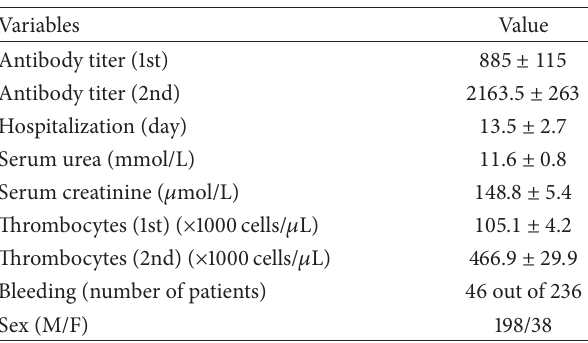
Table 1: Clinical characteristics of NE